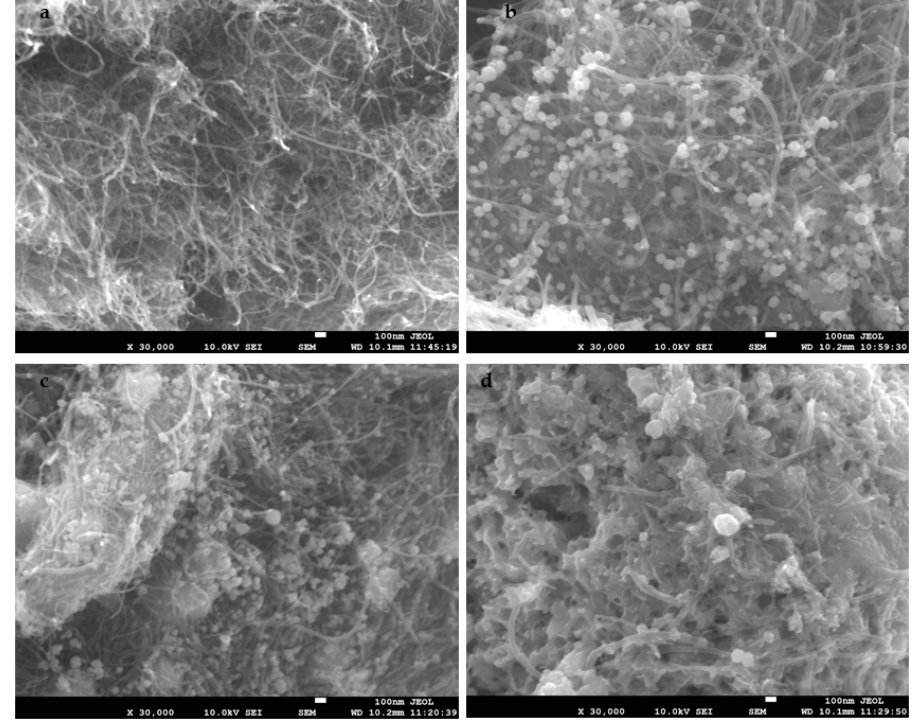
Figure 7. SEM images of 5%Re/CNTs ( a ); 5%Re ‐ 30%PW 12 /CNTs ( b ); 5%Re ‐ 30%PW 12 /CNTs 6 h post ‐ reaction ( c ) and 5%Re ‐ 80%PW 12 /CNTs ( d ).